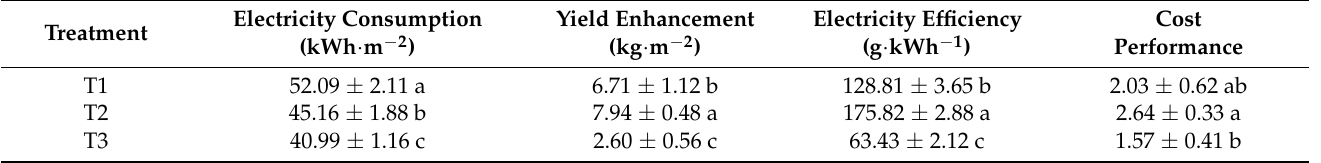
Table 6. Economic analysis of different abaxial leafy supplemental lighting